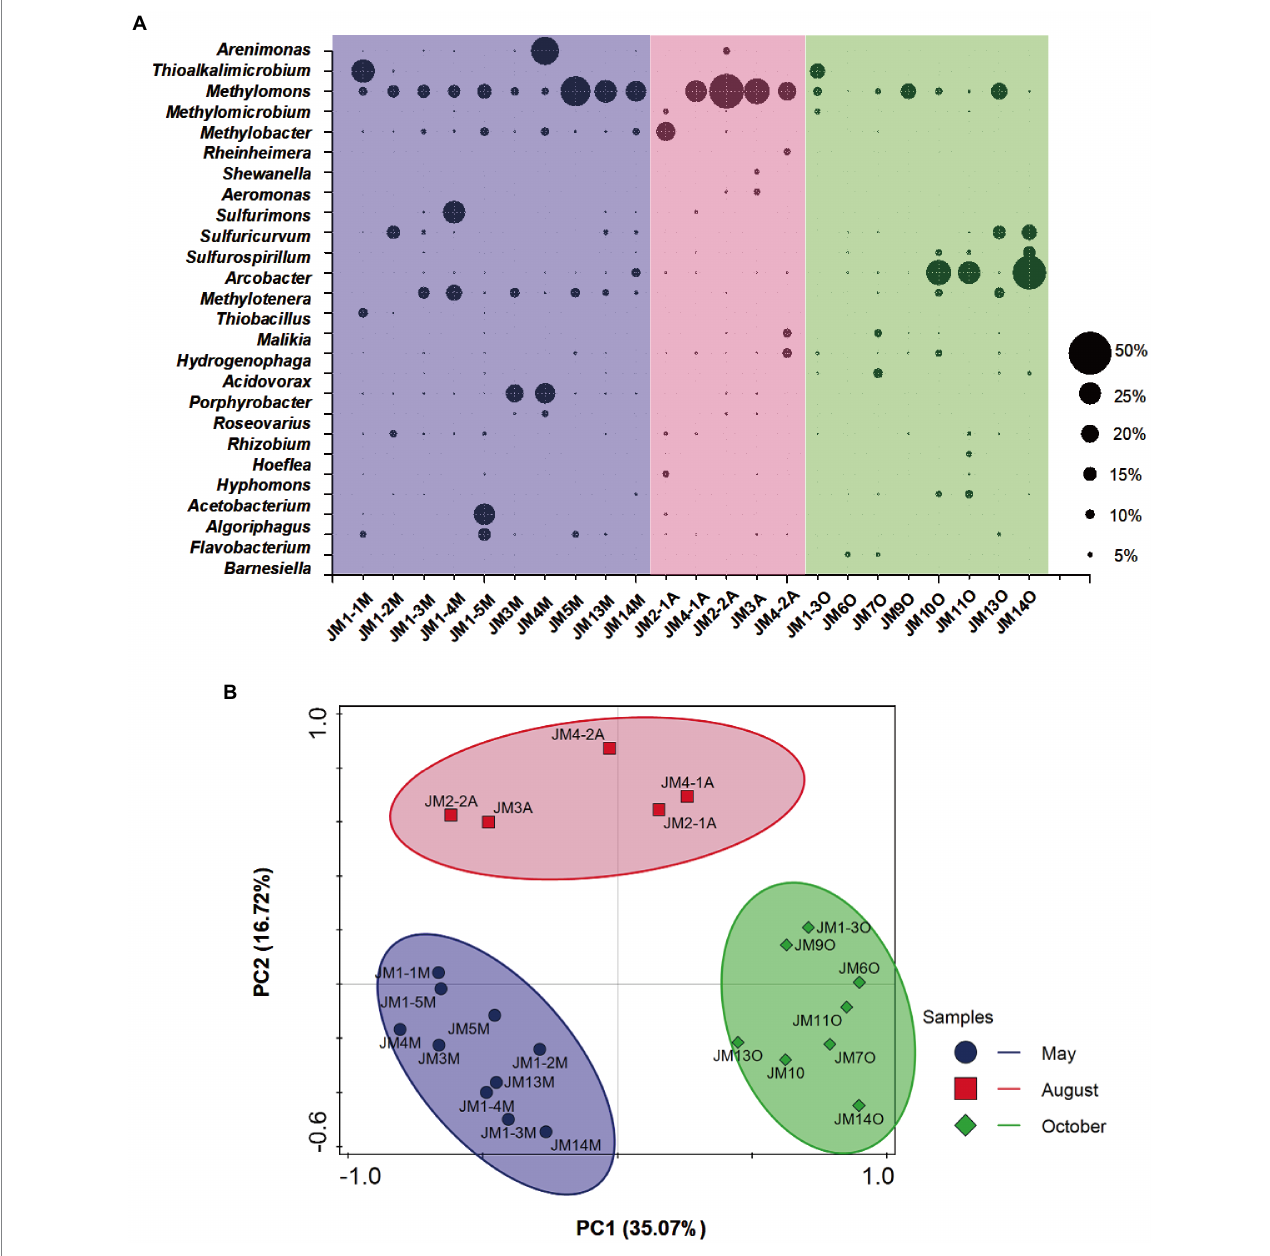
FIGURE 1 (A) Responses of bacterial community structure to seasonal variation in coalbed water based on 16S rRNA gene. The suffix letter of each sample name represents the month in which the sample was taken (M: May; A: August; O: October). The size of the bubble represents the relative abundance of the genus in each sample. (B) Principal components analysis (PCA) of bacterial 16S rRNA gene retrieved from coalbed water. Different symbols and colors represent different sampling months (purple circle: May; red square: August; green diamond: